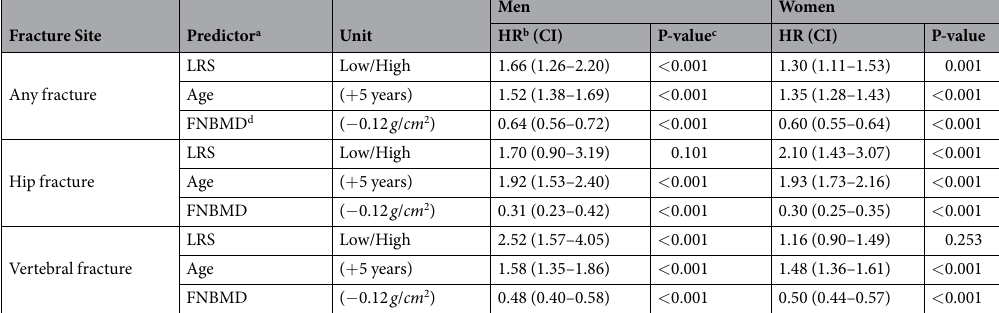
Table 3. Prediction of fracture risk using univariate Cox Proportional Hazards Analysis. a LRS: Lifestyle Risk Score. LRS in Low/High. Age in ( + 5 years). Weight in (kg). BMI in ( kg = m 2 ). FNBMD: Femoral neck bone mineral density. b HR: Hazard ratio. 95% CI: Confidence intervals of the hazard ratio. c P-value: Global statistical significance of the model. d FNBMD: Femoral neck bone mineral